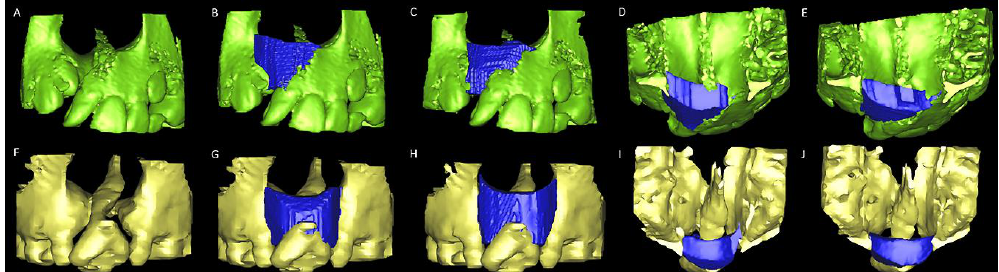
Figure 1. The 3D-printed models for alveolar bone graft surgery simulation. ( A ) Unilateral alveolar cleft models displaying ( B ) the superior, inferior, ( C ) anterior, and posterior borders of unilateral alveolar cleft defects filled with simulated bone graft tissue (red modeling clay) in two models with different densities of computed tomography (CBCT) from the same patient with complete unilateral cleft lip and palate. ( D ) Bilateral alveolar cleft models displaying ( E ) the superior, inferior, ( F ) anterior, and posterior borders of a bilateral cleft defect filled with simulated bone graft tissue (red modeling clay) in two models with different densities of CBCT from the same patient with complete bilateral cleft lip and palate.